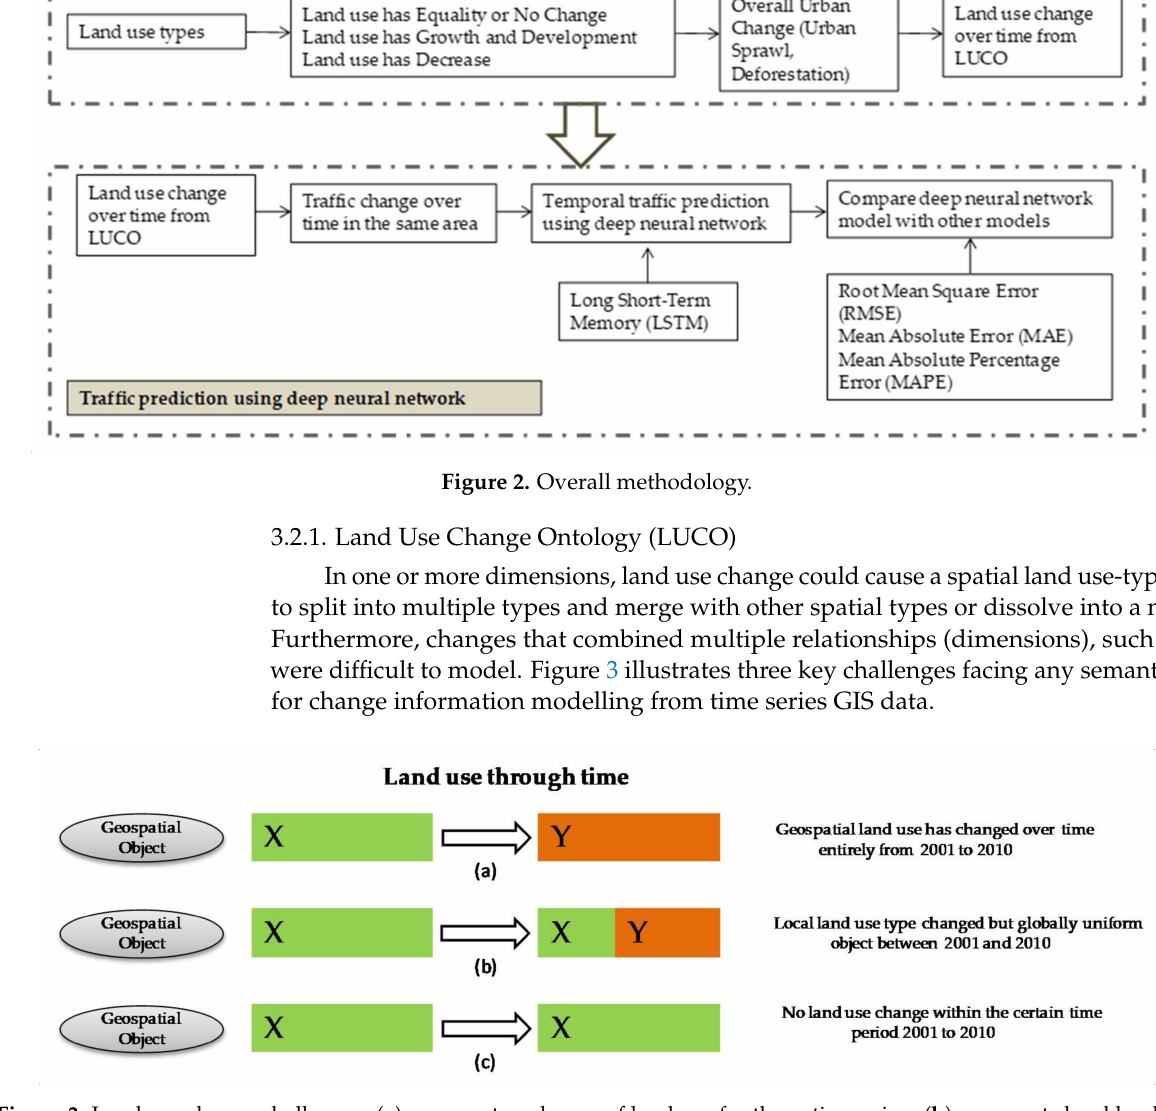
Figure 3. Land use change challenges. ( a ) represents a change of land use for the entire region; ( b ) represents local land use change of a region; ( c ) represents no changes in land uses within a certain time